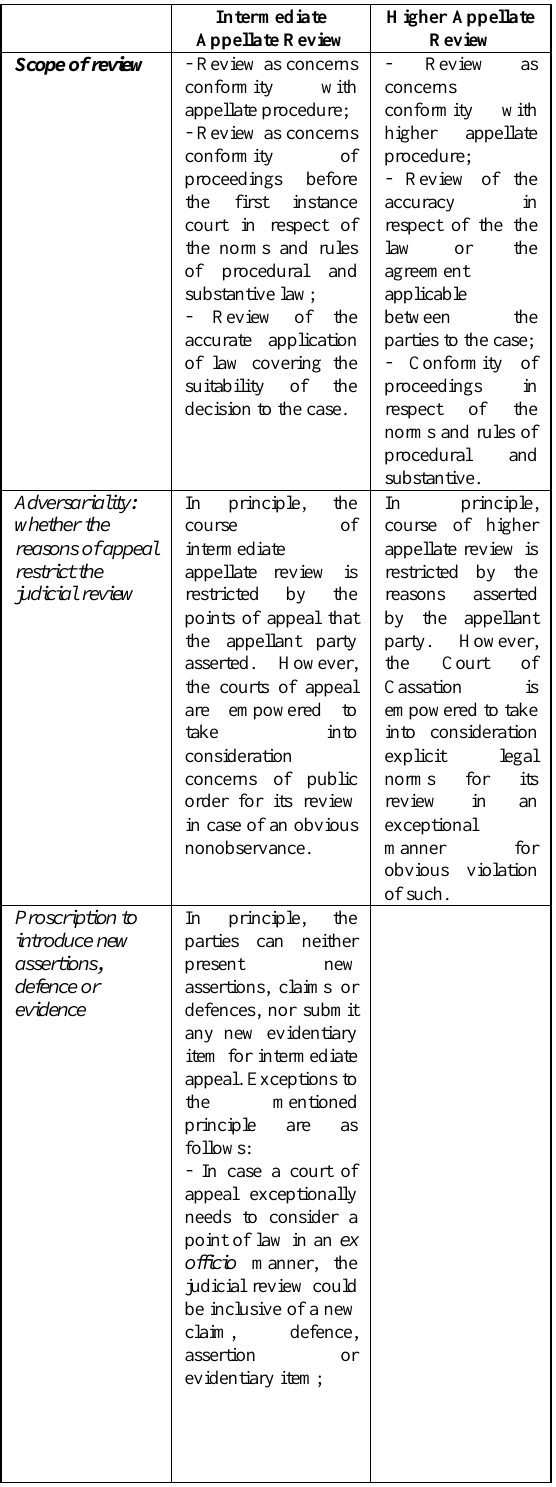
Table 4. Scope of Intermediate Appellate